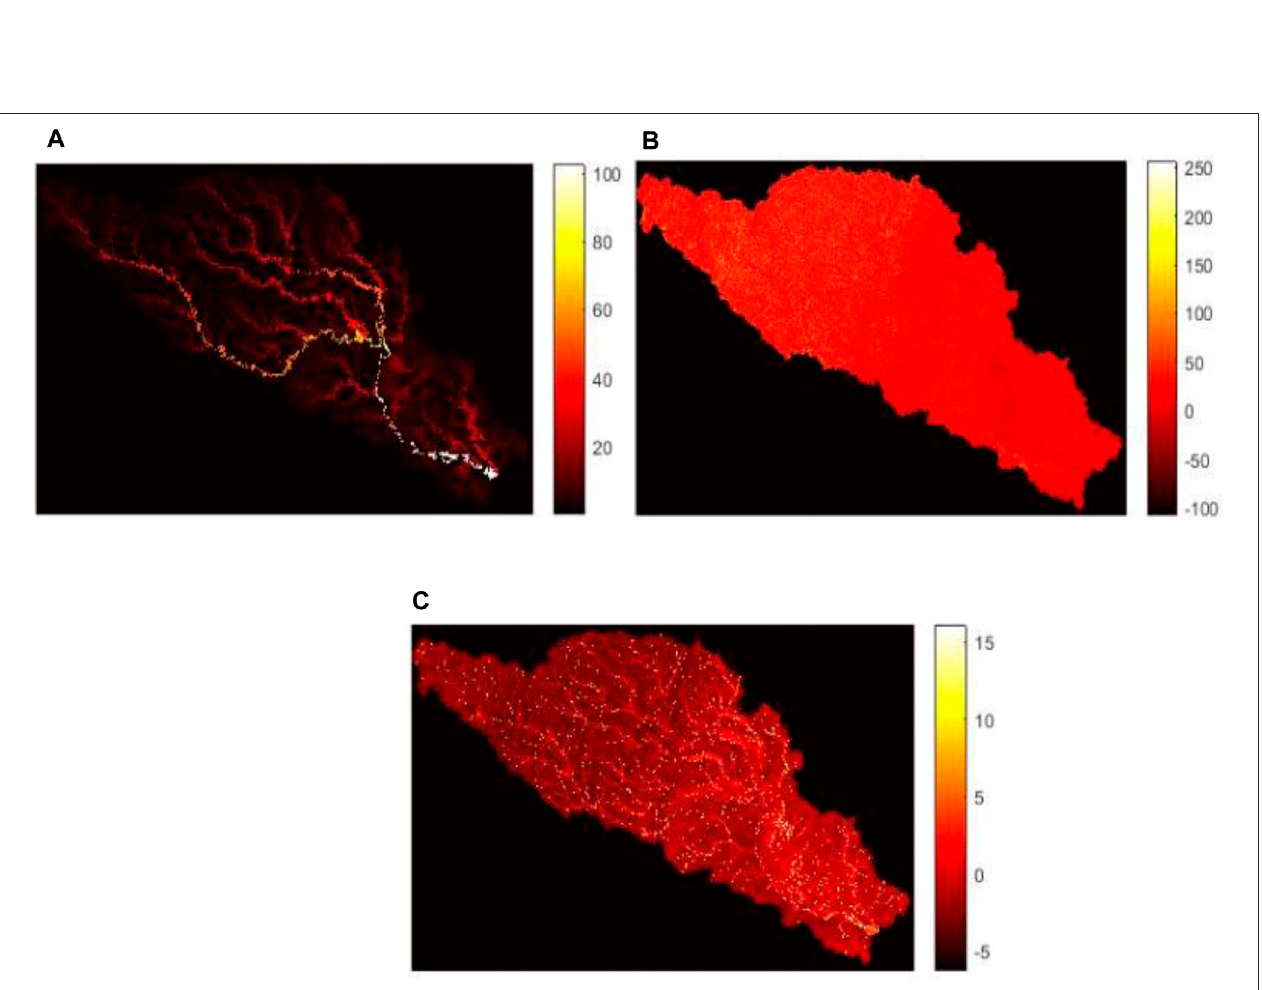
Frontiers in Remote Sensing |